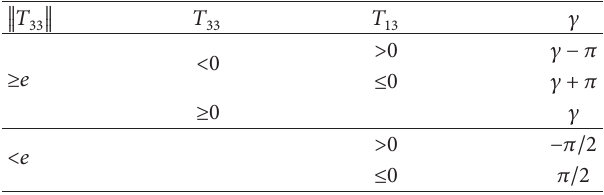
Table 1: The roll angles of body.